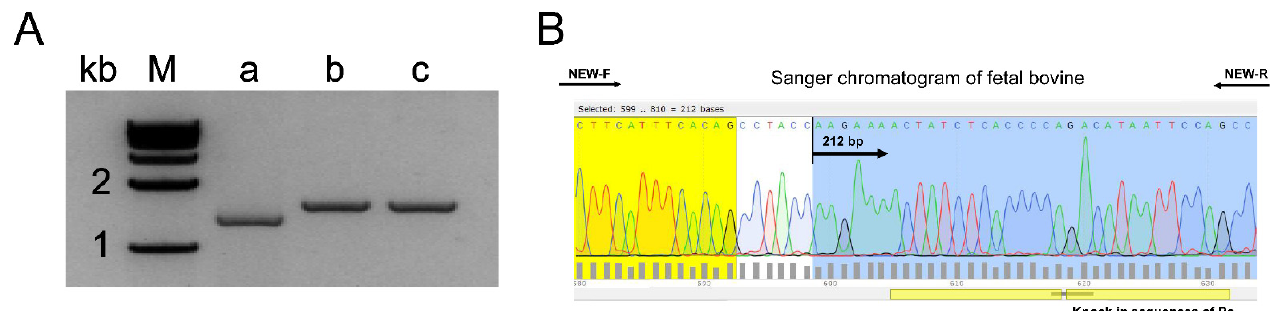
Figure 4. Fetal cow genome test results. ( A ) Results of agarose gel electrophoresis of PCR amplifica- tion products from gene edited hornless bovine fetuses. (a) Whole genome of Holstein 3-month-old horned fetus. (b) Cell line obtained by pure insertion of gene editing Pc locus. (c) Whole genome of Holstein 3-month-old polled fetus obtained by pure insertion of gene editing Pc locus. ( B ) Sanger chromatogram of fetal bovine with the Pc locus homozygous insertion.